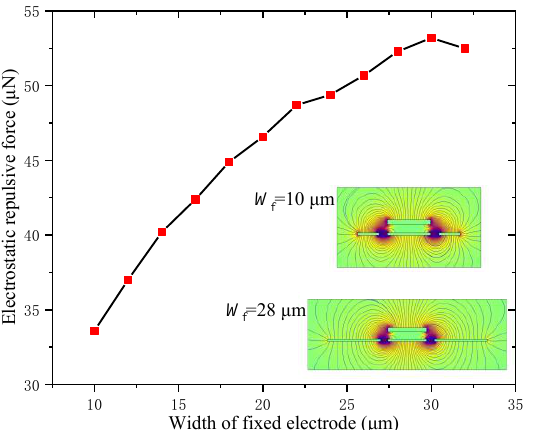
Figure 8. Electrostatic repulsive force versus the width of fixed electrode ( V = 500 V, d 1 = d 2 = 4 μm, W m = 20 μm and h m = 2 μm).